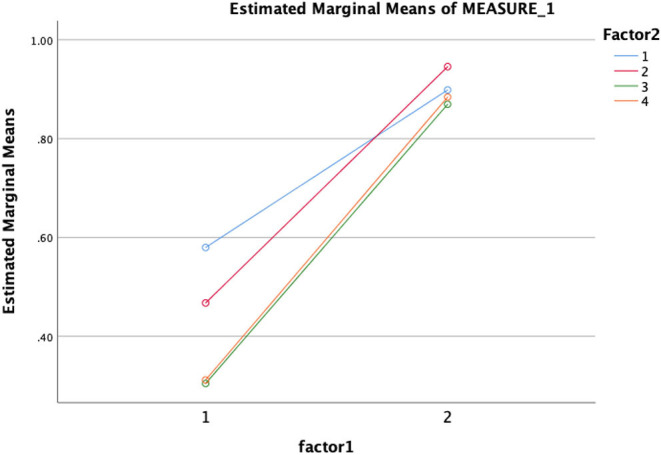
Multivariate tests.